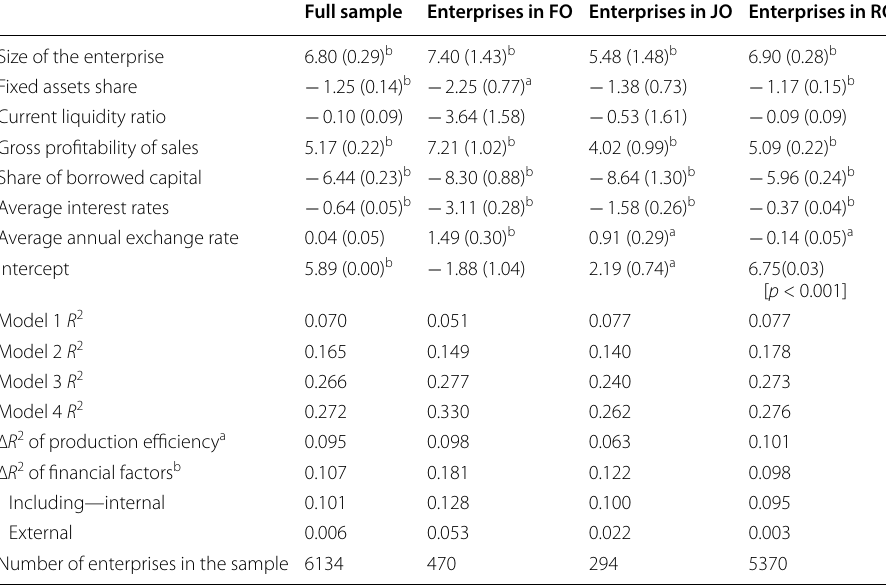
Standard errors are in parentheses. The coefficients and standard errors are given according to model 4. All constructed models (models No. 1–4) are highly significant for all samples ( p ≪ 0.0001) a ∆ R 2 of production efficiency is calculated as the difference of R 2 (model 2) and R 2 (model 1) or it is equal ∆ R 2 (model 2) b ∆ R 2 of internal financial factors is calculated as the difference of R 2 (model 3) and R 2 (model 2) or it is equal ∆ R 2 (model 3). R 2 of external financial factors is calculated as the difference of R 2 (model 4) and R 2 (model 3) or it is equal ∆ R 2 (model